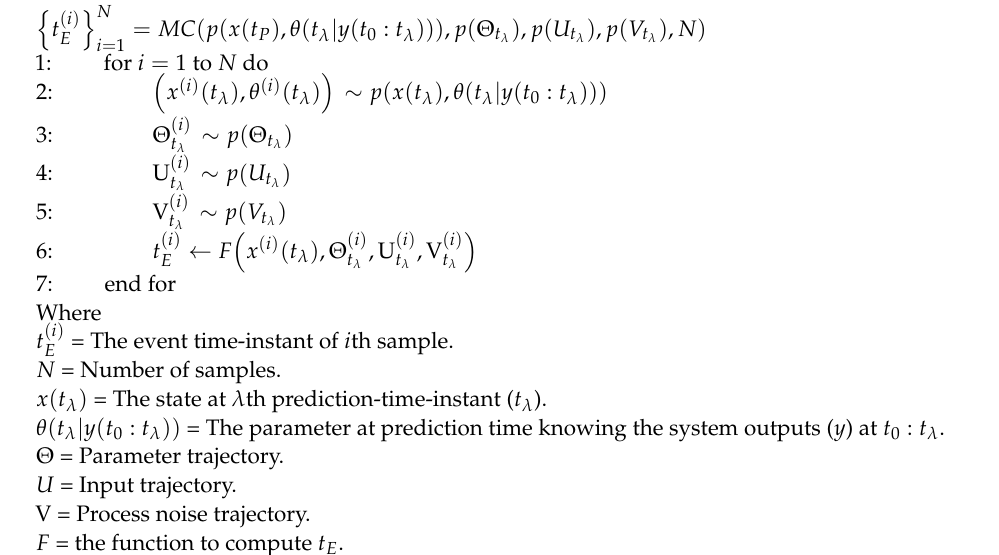
Algorithm 1: Monte Carlo Prediction